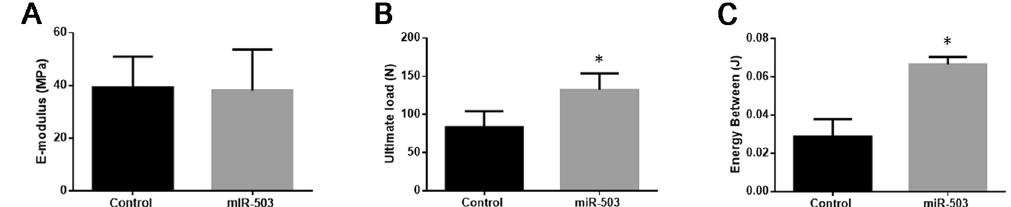
Figure 6. Bone healing property is enhanced by miR-503 overexpression therapy. Mechanical test was performed on the lengthened tibia after all the animals sacrificed at day 44 postoperation. Form the results, no significant differences was found in E-modulus ( A ) between these two groups. However, ultimate load ( B ) and energy between ( C ) were much higher in miR-503 group than that in control group (n = 10 each group, * P < 0.05).